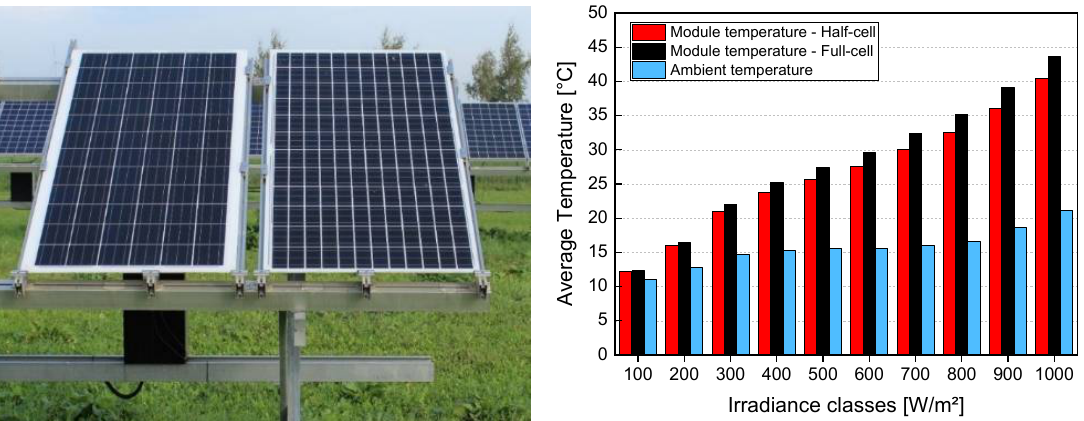
Figure 12. ( left ) Measurement of full-cell and half-cell modules with uniform design on the outdoor test field in Germany, and ( right ) average measured temperature of the ambient, half-cell and full-cell modules between 2014 and 2018.